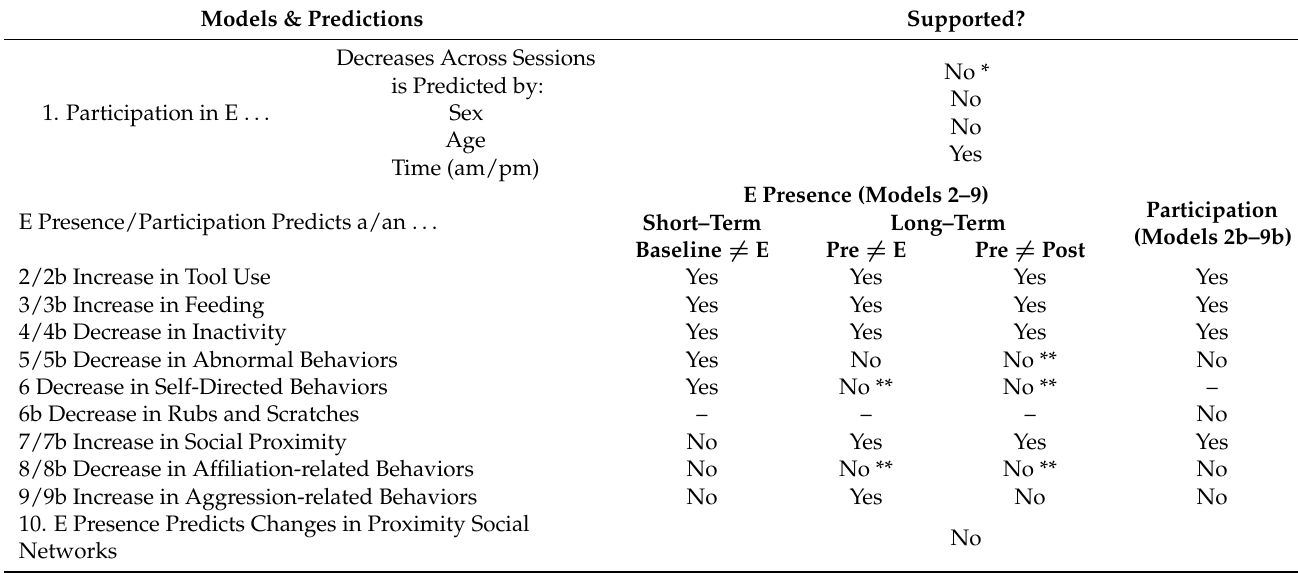
Table 2. Summary of predictions and results for all